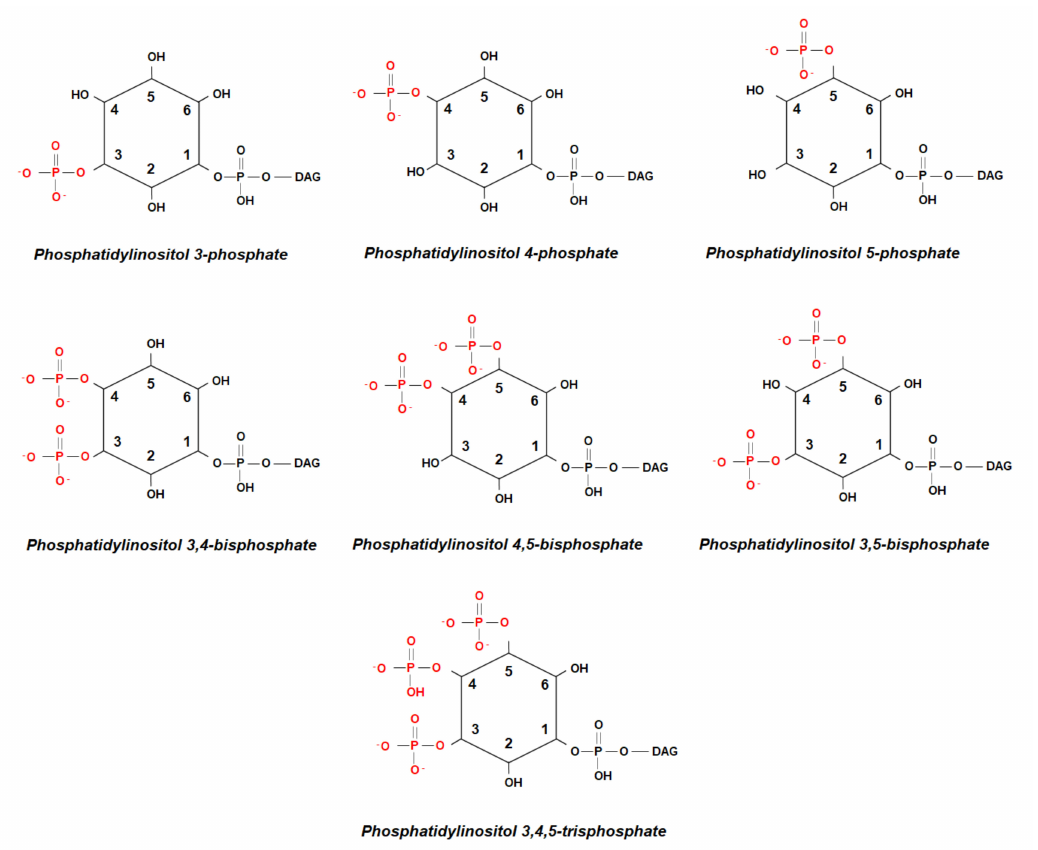
Figure 2. Schematic representation of the seven